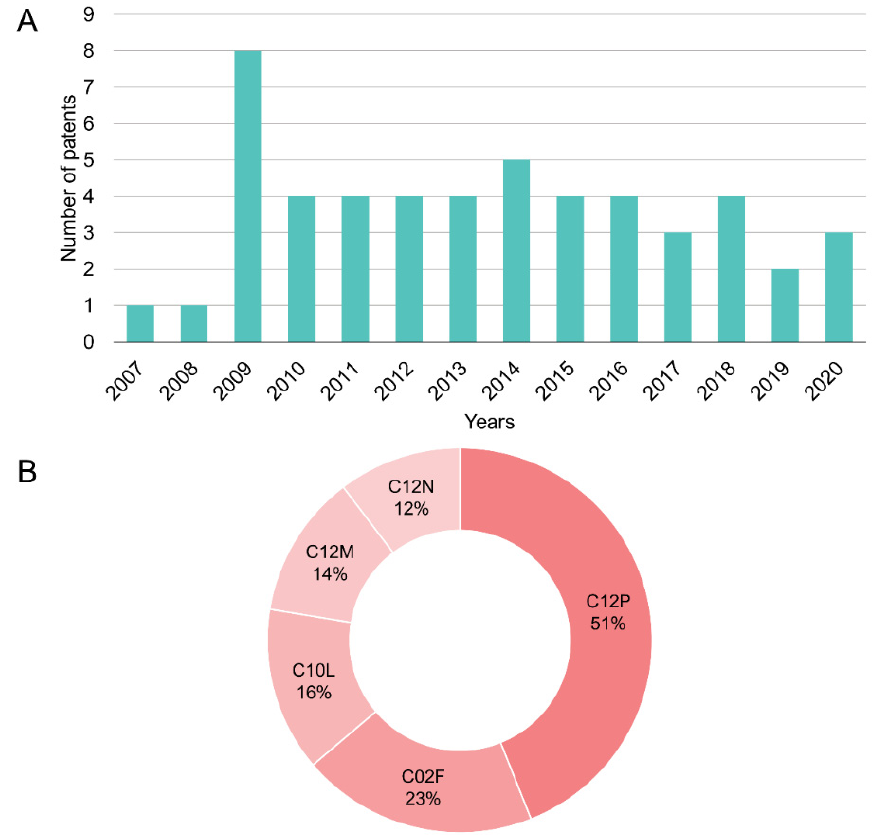
Figure 2. Search for patent documents in the Derwent Innovations Index database: ( A ) distribution of patent documents per year. Keywords: TS = (sugarcane or cane or sugar cane) and (vinasse or effluent or waste water or wastewater) and (biomethane or methane or CH 4 or biogas), period 2005–2020. Date of search: 9 December 2020; ( B ) distribution of patent documents according to WIPO’s International Patent Classification codes (IPC): C12P (fermentation or enzyme processes); C02F (treatment of water); C10L (fuels); C12M (apparatus for enzymology or microbiology); C12N (microorganisms or